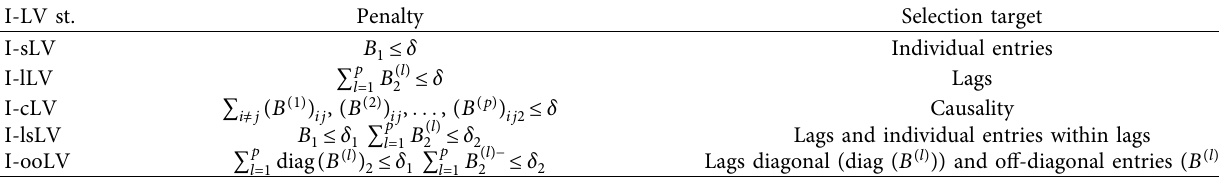
Table 1: Brief description of Ivanov-based LASSO-VAR structures. I-LV